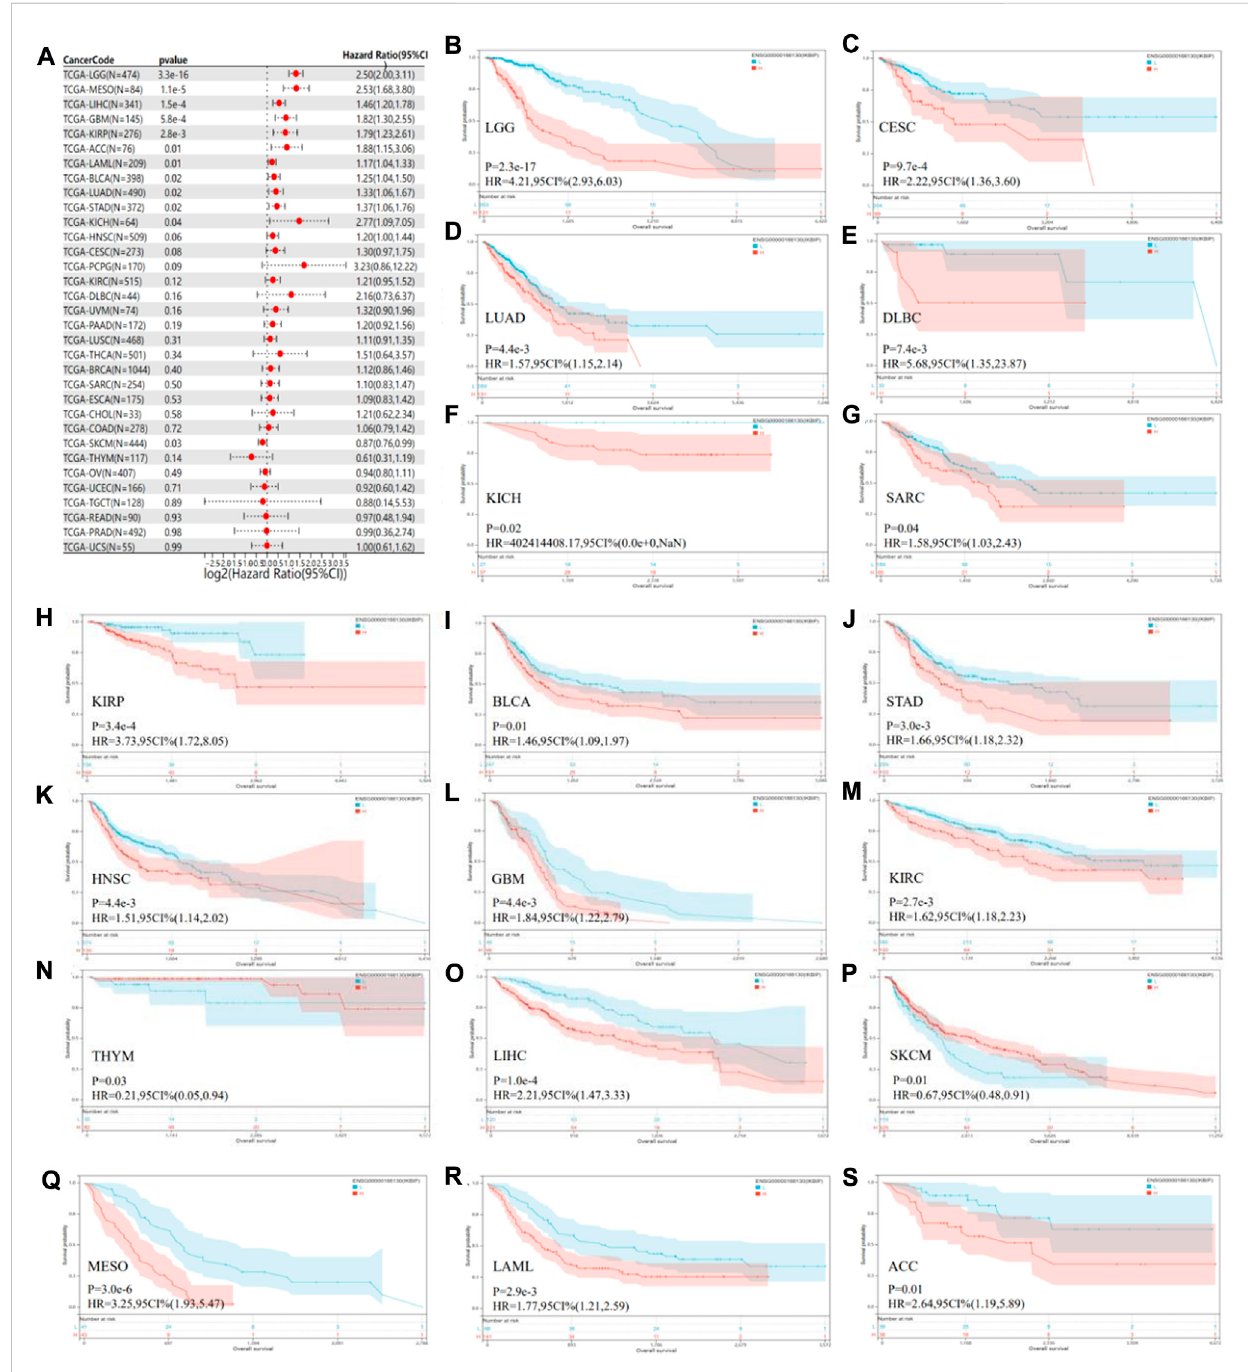
FIGURE 3 Pan-cancerOSstudyofIKBIP. (A) IKBIPpan-cancerhazardratiosaredisplayedonaforestplot. (B – S) TCGAdatabaseanalysisofpan-cancersurvival curves with high and low IKBIP